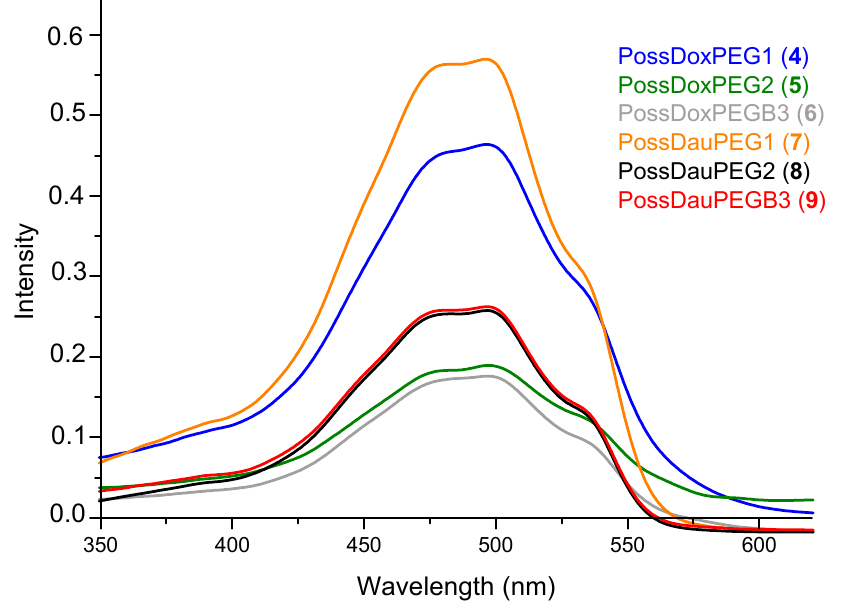
Figure 3. Measurement of maximum contents of DOX and DAU released from the relevant conjugates ( 4 – 9 ) (by mixing with HCl (36%) at 50 °C).